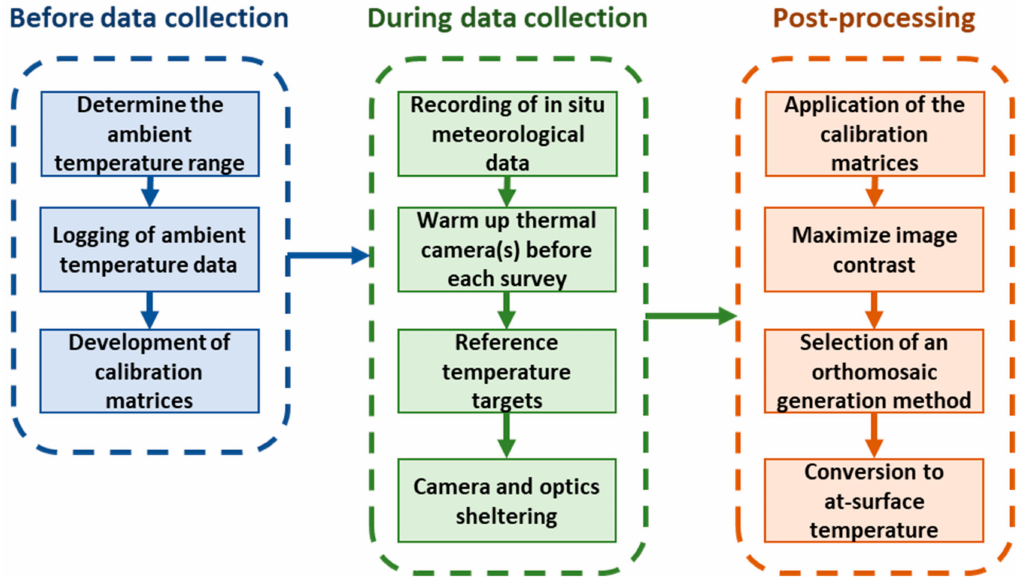
Figure 12. Proposed workflow for conducting a thermal data collection survey. The first step is the derivation of the calibration equations / matrices for the thermal sensor inside an environmental chamber. Next is the surveyed site setup and recording of ancillary data during the thermal data collection. The last step represents the application of the calibration equations / matrices to the collected thermal data, contrast maximization, the selection of an appropriate mosaicking algorithm, and